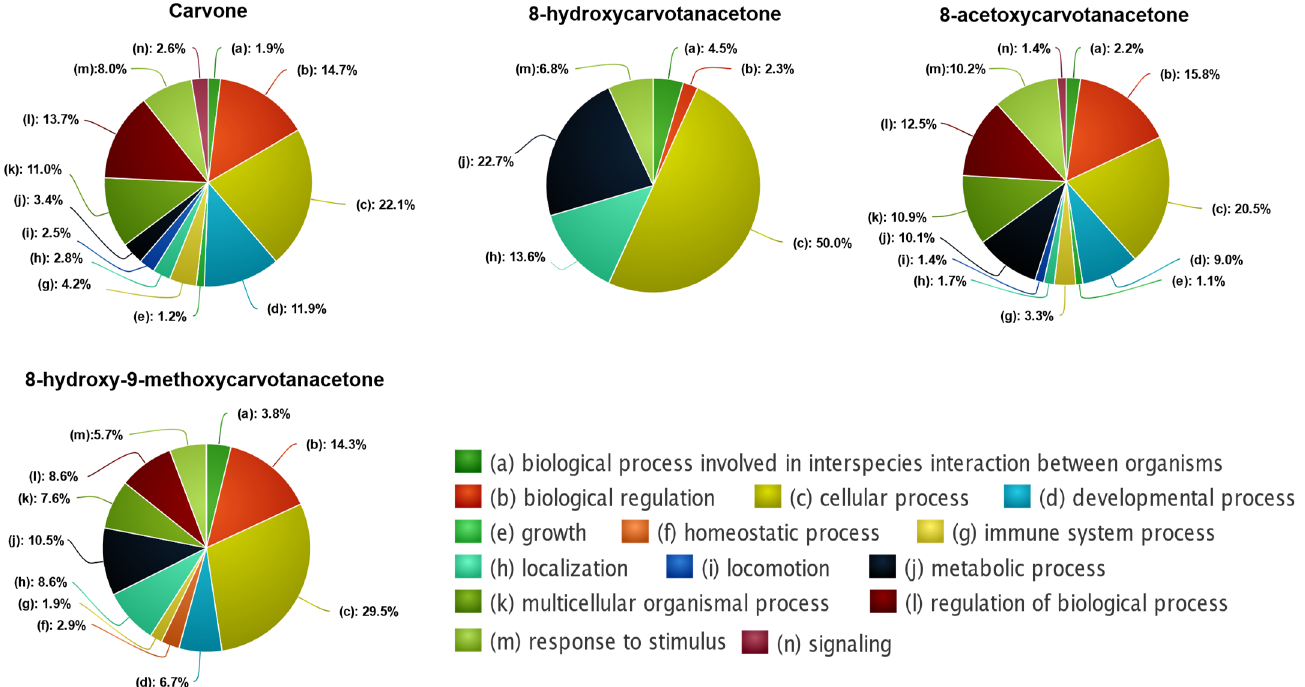
Figure 5. Functional enrichment analysis of the biological processes predicted to be affected by the 4 structures tested, according to the DTI prediction model.